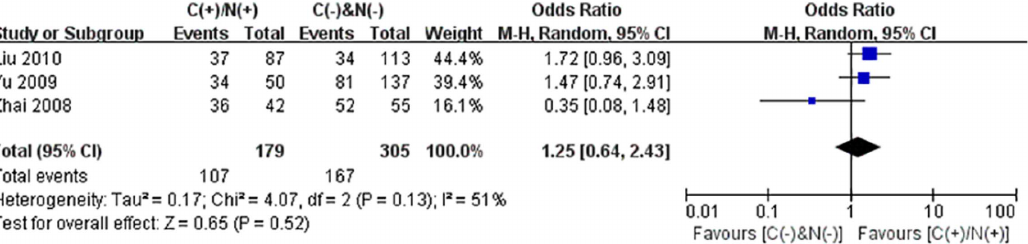
Figure 10. Forest plot of odds ratio for the association of b -catenin expression in cytoplasm and/or nucleus with Tumor encapsulation.